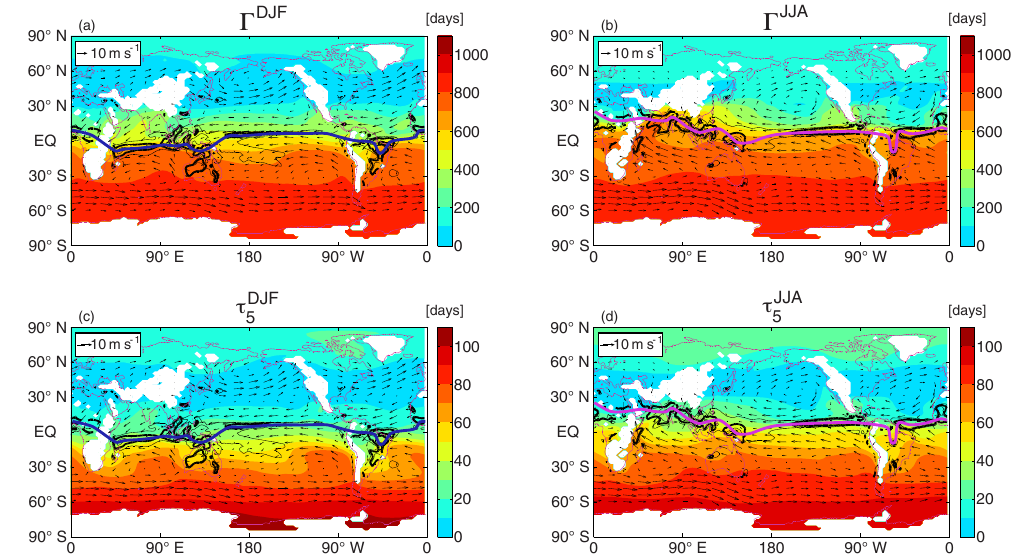
Figure 2. Climatological mean (cid:48) and τ 5 at 900hPa for (a, c) DJF and (b, d) JJA. Arrows show horizontal velocity, black contours convergence at 900hPa (contours at ( − 3, − 2, − 1) × 10 6 s − 1 , with − 2 × 10 6 s − 1 bold), and blue and pink curves show the approximate location of the